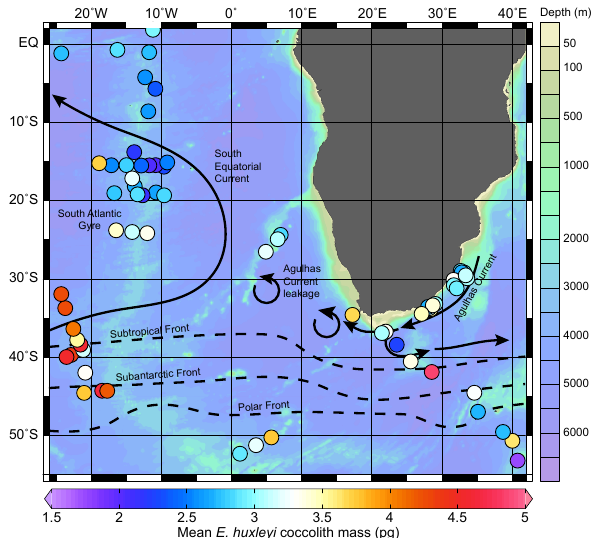
Fig. 1. Distribution map of the studied sites (circles). The color of the symbols (scale at the bottom) refers to the averaged mass of E. huxleyi coccoliths measured at the different sites. The bathymetry is given by the scale on the right side. The surface hydrography is depicted by the black arrows and the main fronts by the dotted